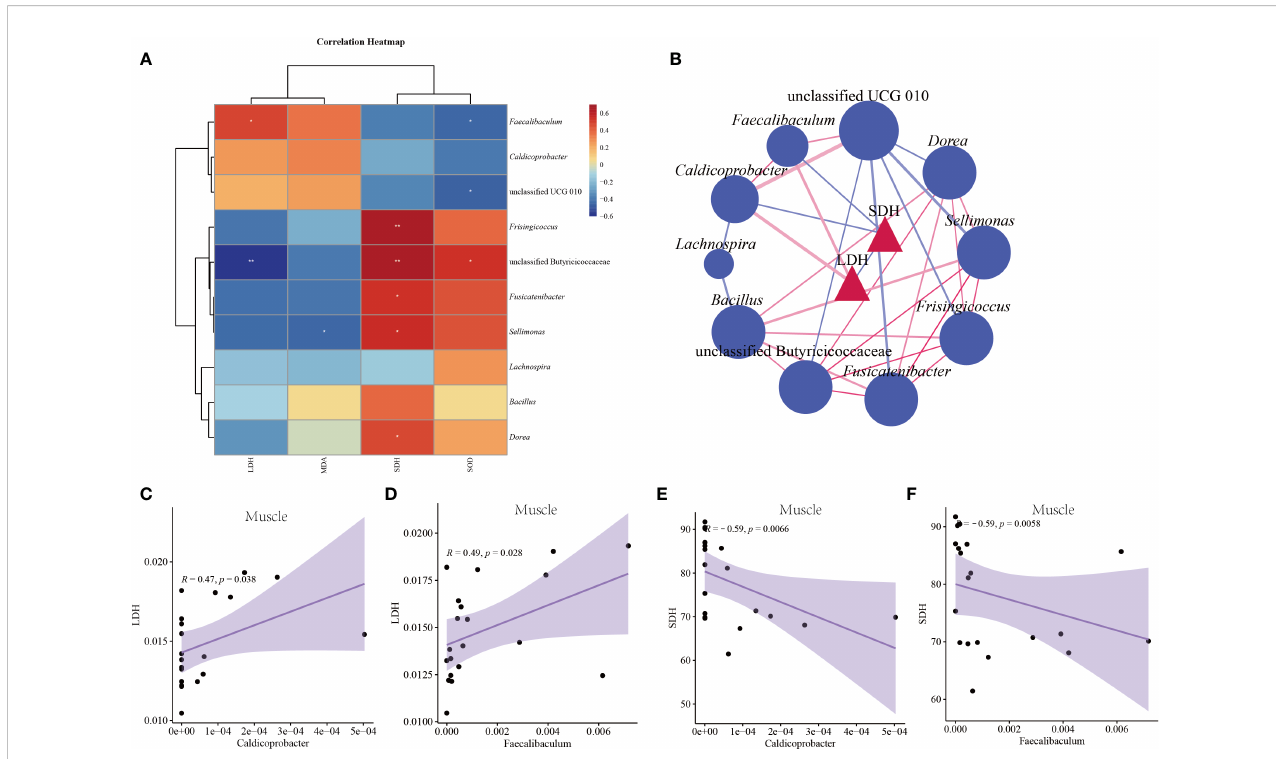
FIGURE 9 Correlation between characteristic bacteria of intestinal contents and indexes in mice. (A) Correlation heat map between characteristic bacteria and liver indexes. (B) Association network diagram of pathogenic bacteria and muscle indexes. (C) Scatter diagram of muscle LDH and Caldicoprobacter . (D) Scatter diagram of muscle LDH and Faecalibaculum . (E) Scatter diagram of muscle SDH and Caldicoprobacter . (F) Scatter diagram of muscle SHD and Faecalibaculum . CC: control group, CL: low-dose GFPS group, CM: medium-dose GFPS group, CH: high-dose GFPS